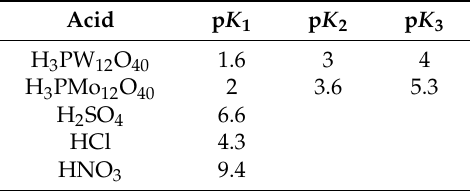
Table 2. Dissociation constants of heteropoly acids in acetone at 25 ◦ C [38].